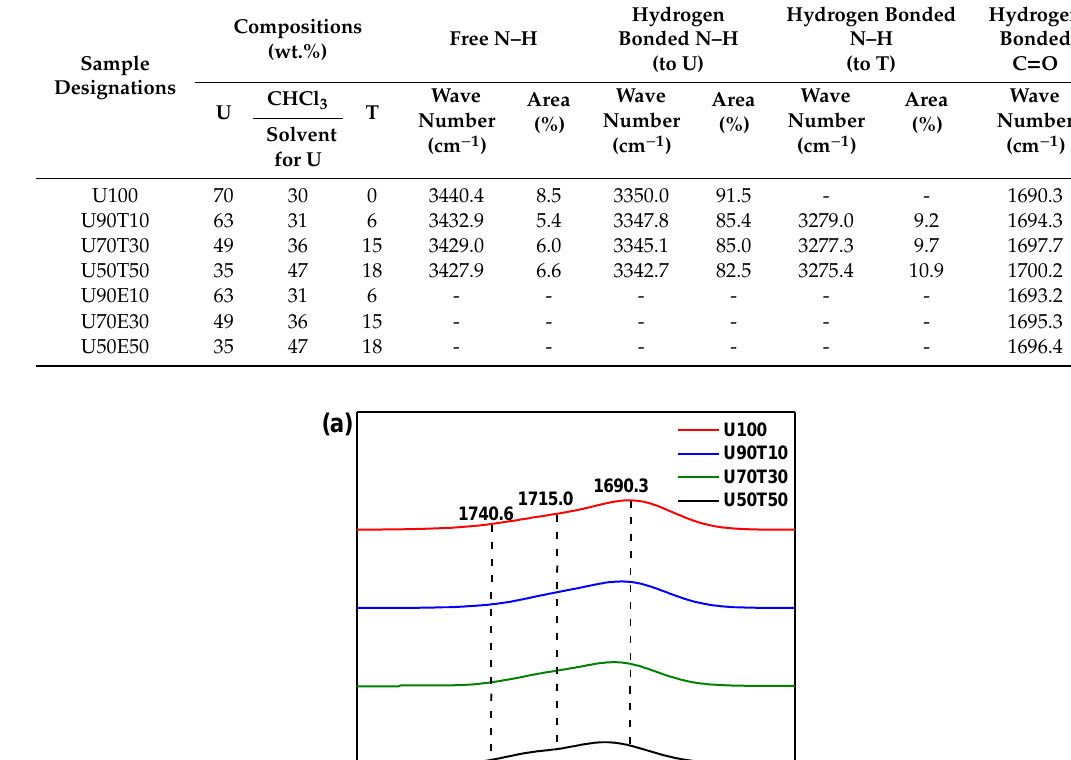
Table 3. Designations and compositions of the samples used in the model system and the characteristics of the N–H and C = O bands in the FT-IR spectra. U, T, and E stand for ethyl- N -methylcarbamate, tetrahydrofuran, and diethyl ether, respectively.